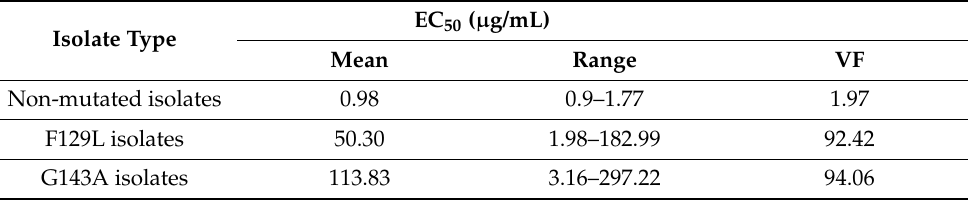
Figure 4. In vitro sensitivity of A. flavus isolates to azoxystrobin. Table 2. Mean and range of effective concentration inhibiting 50% (EC 50 ) growth of A. flavus